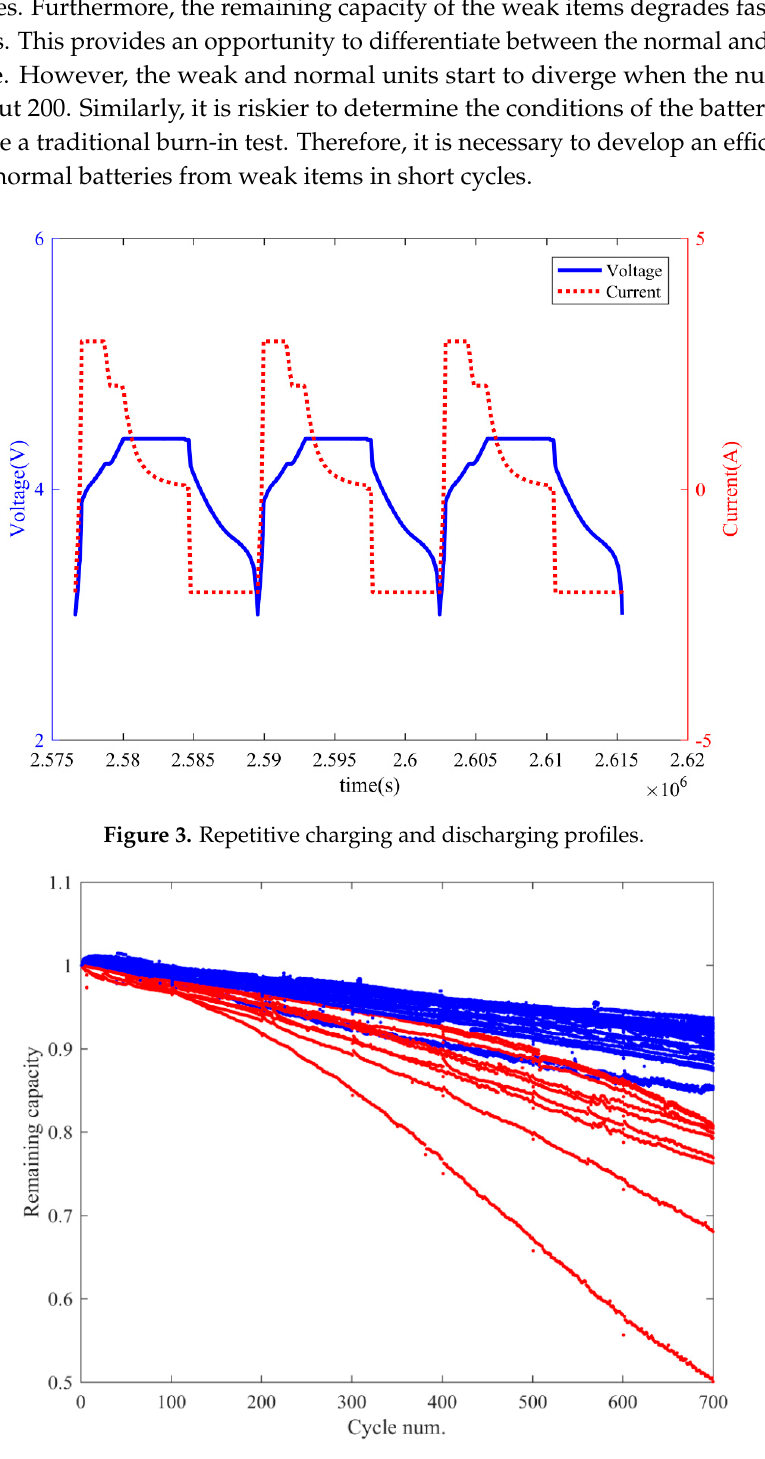
Figure 4. Remaining capacities of selected battery samples.